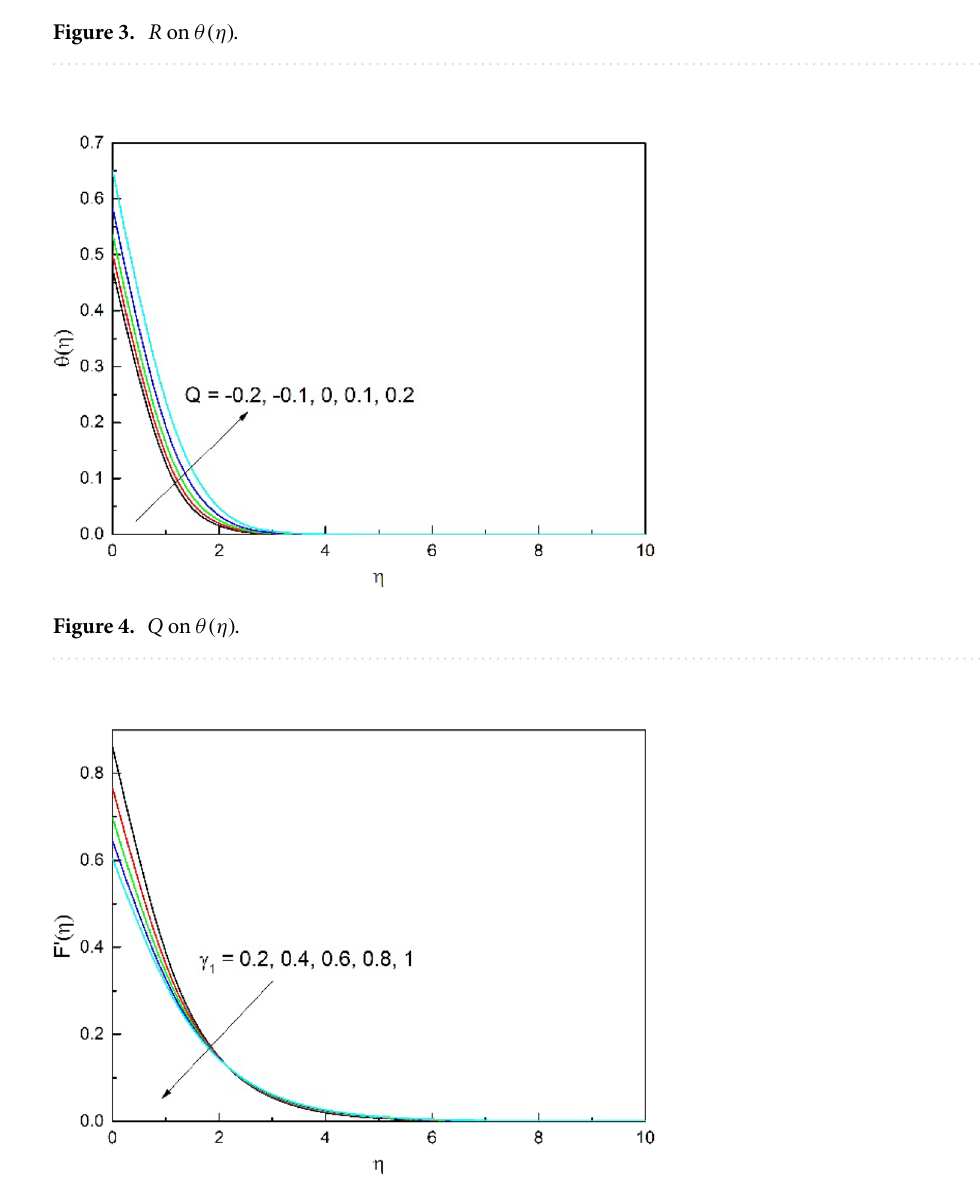
Figure 5. γ 1 on F ′ (η)